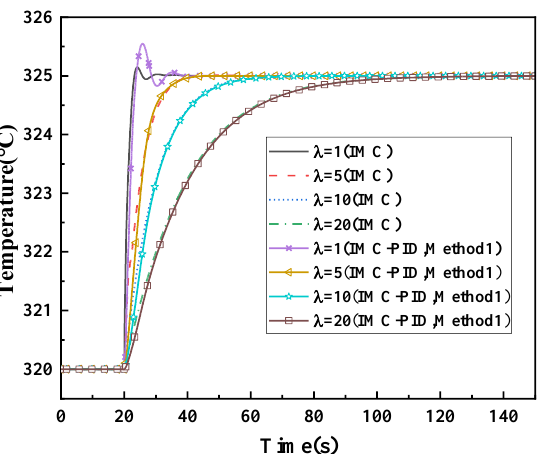
Figure 10. Comparison of IMC and IMC-PID performance under different parameters.